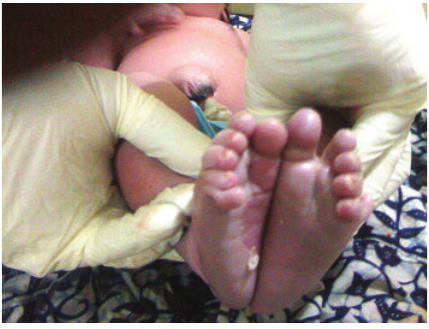
Figure 3: Shows both feet with the extra